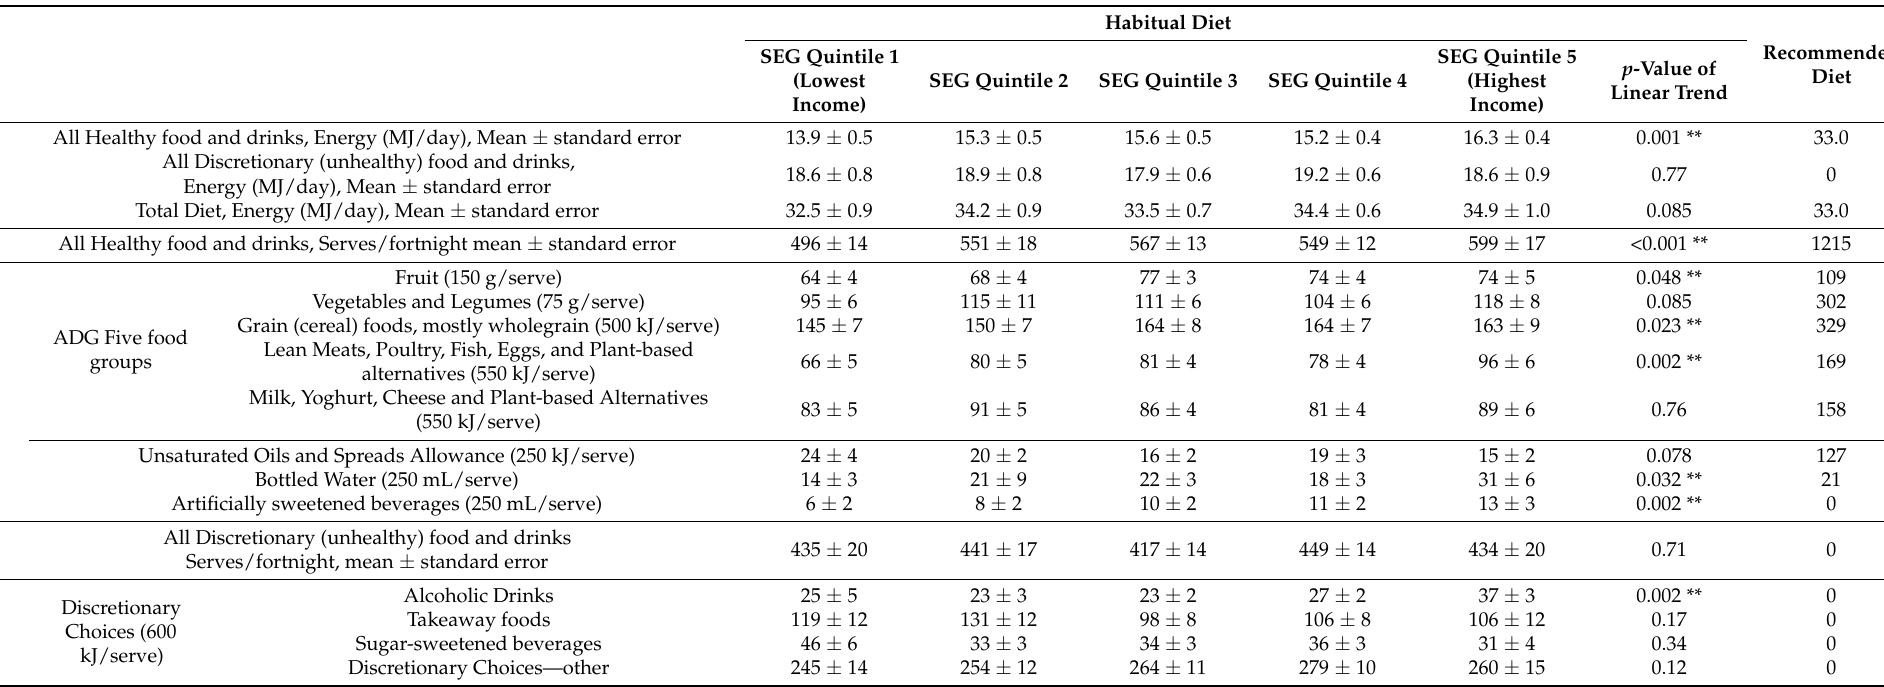
Table 2. Energy (MJ/day) and ADG food intake (serves per fortnight) of habitual diets across SEGs, and recommended diet, for a reference household (two adult, two children) per